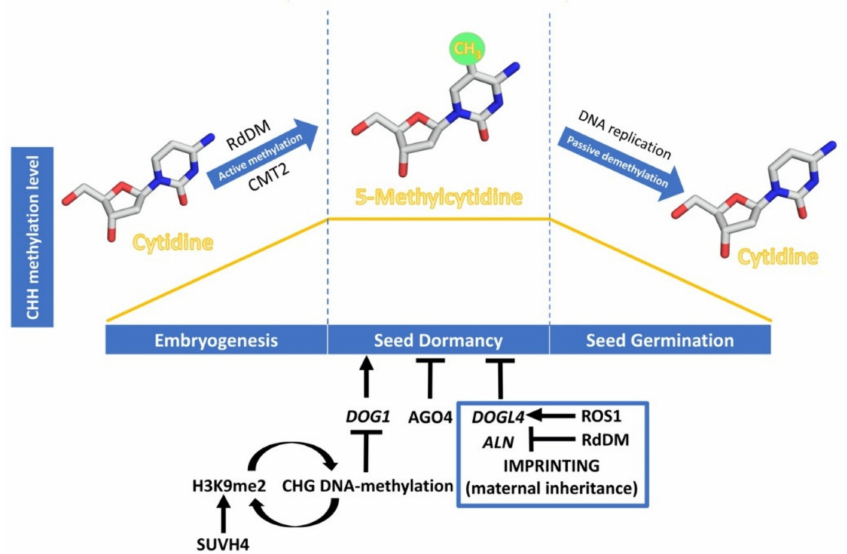
Figure 2. Dynamics of CHH DNA methylation (orange line) during seed development, and epigenetic regulation of seed dormancy. The DNA methylation process has been schematised with cytidine and 5-methylcytidine molecules designed using Chimera 1.14 [98]. Epigenetic regulation of seed dormancy has been schematised with arrows indicating a promotive e ff ect and bars indicating a repressive e ff ect. Regulation through genomic imprinting is indicated within the blue